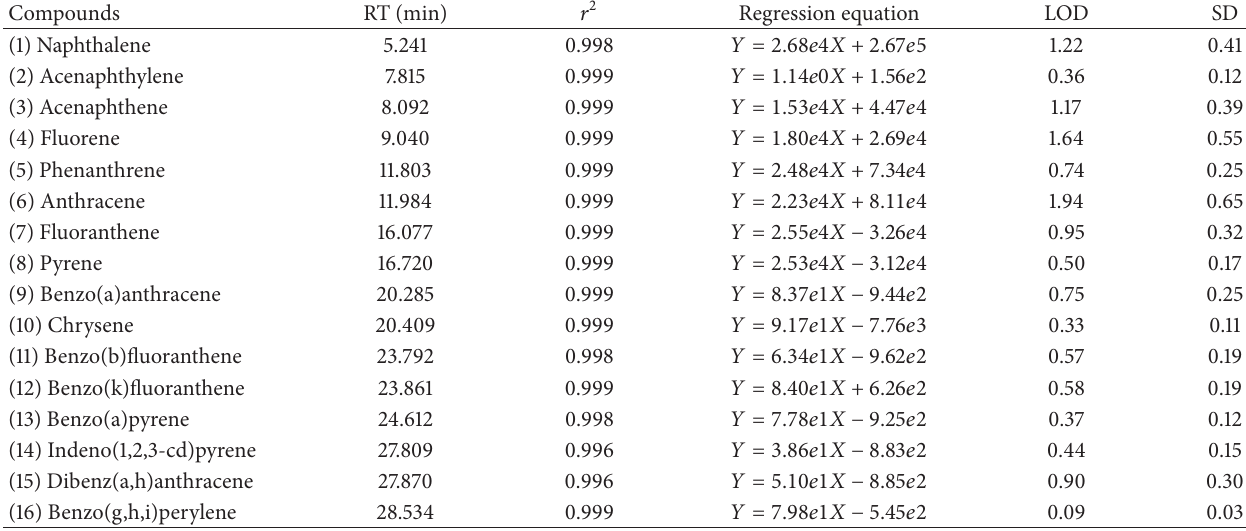
Table2:Retentiontimes(RT),regressioncoefficient( 𝑟 2 ),regressionequation,limitofdetection(LOD),andstandarddeviation(SD)obtained for standards in toluene calibration.